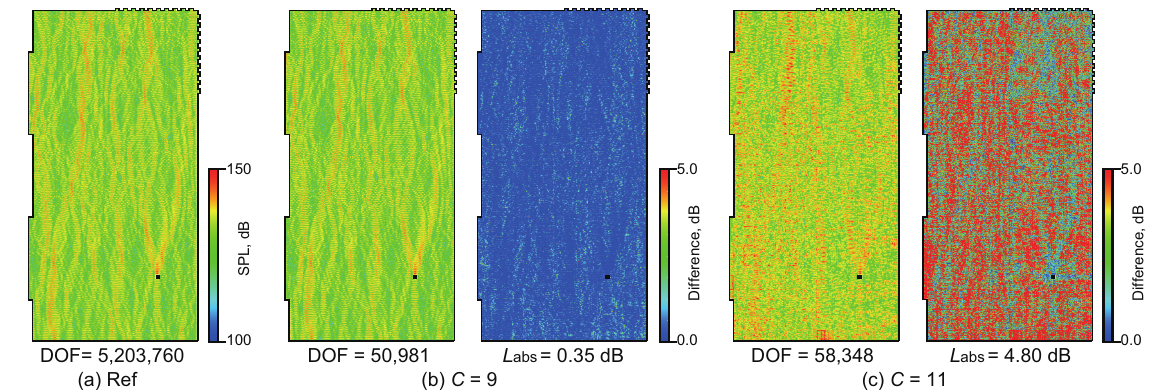
Figure 8. A comparison of the SPL distribution at 4 kHz of the reference solution and the PW-FEM using Mesh 2 with C = 9 and C = 11 and the SPL difference from the reference